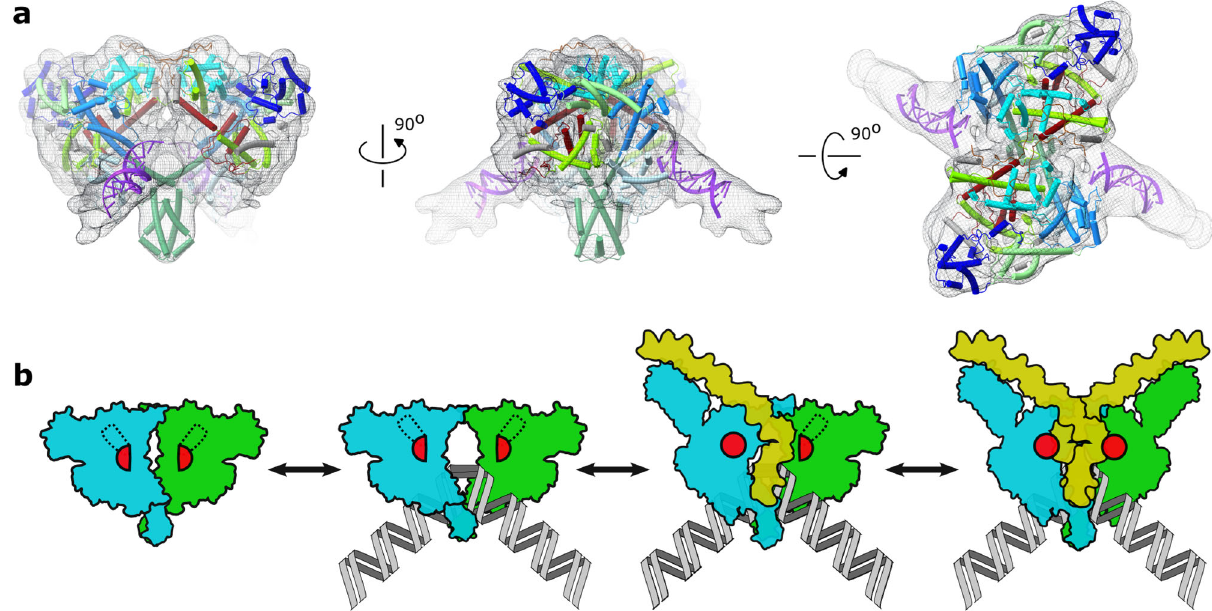
Fig.6|Structureofnon-activatedapo-likestatewithboundDNAandproposed mechanism of transpososome assembly. a Low-resolution cryo-EM map and fi t- ted structure of TnpA WT with bound IR100. TnpA WT is shown in cartoon repre- sentation with domains color coded as in Fig. 1. The bound DNA, shown in purple, has position similar to outer fl anking segment in TnpA S911R -IR100 complex. In this